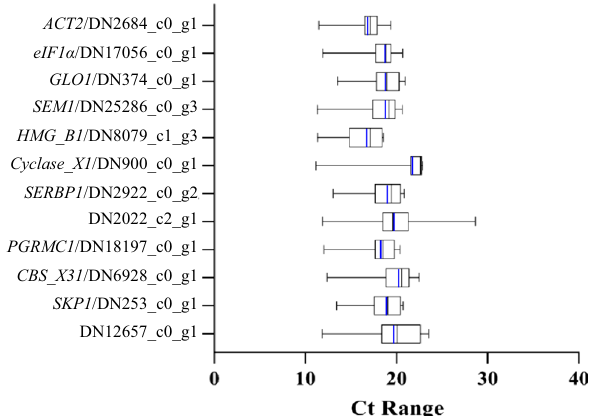
Figure 3. Variation of qRT-PCR Ct values for candidate RG and controls across diverse tissues in A. tuberosum . The vertical blue and black lines in the box show the mean and median values, respectively. The lower and upper boxes indicate the first and third quartile.